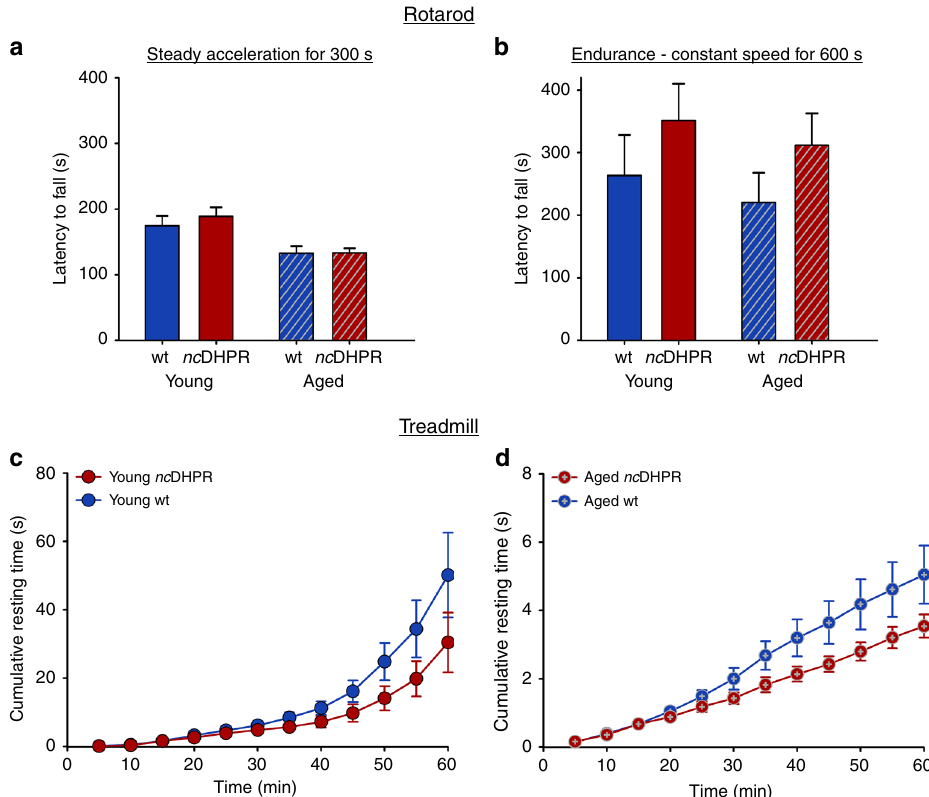
Fig. 8 DHPR Ca 2+ in fl ux has no impact on whole animal muscle endurance and fatigue. a In Rotarod performance test, the mean latency to fall from a rotating rod under steady acceleration (4 – 40 rpm for 300 s) was indistinguishable ( P > 0.05) when young (188.78 ± 13.95 s; n = 16) and aged nc DHPR (133.36 ± 6.73 s; n = 26) mice were compared with their wt (174.50 ± 15.02 s; n = 16 and 132.85 ± 10.19 s; n = 28, respectively) counter mates. b The mean latency to fall during 600-s Rotarod endurance task at constant speed, 20 rpm or 15 rpm in young or aged mice, respectively, was indifferent ( P > 0.05) between age-matched nc DHPR (young: 351.54 ± 58.64 s; n = 16 and aged: 312.22 ± 50.76 s; n = 25) and wt (young: 263.43 ± 64.66 s; n = 16 and aged: 220.67 ± 47.32 s; n = 27) mice. The number of mice that remained on the rotating rod for the entire duration of the task was similar for both genotypes (5 mice each for the young group and 10 aged nc DHPR versus 6 aged wt mice). c Mean cumulative resting time during an intense treadmill run (0.9 km in 1 h) in young nc DHPR (30.45 ± 8.75 s; n = 17) was similar ( P > 0.05) to wt control (50.15 ± 12.36 s; n = 17) mice, indicating unaltered susceptibility to muscle fatigue and endurance. The cumulative number of rests at the end of the task was also indistinguishable ( P > 0.05) between both genotypes (139.94 ± 37.97 for nc DHPR and 232.18 ± 52.89 for wt mice). d Mean cumulative resting time during 1-h treadmill run (0.55 km) in aged nc DHPR mice (3.54 ± 0.34 s; n = 23) was analogous to the wt (5.04 ± 0.85 s; n = 27) siblings. Cumulative number of rests at the end of the task was again comparable ( P > 0.05) between aged nc DHPR and wt mice (19.65 ± 2.27 s and 24.52 ± 3.82 s, respectively). Data are represented as mean ± s.e.m.; P determined